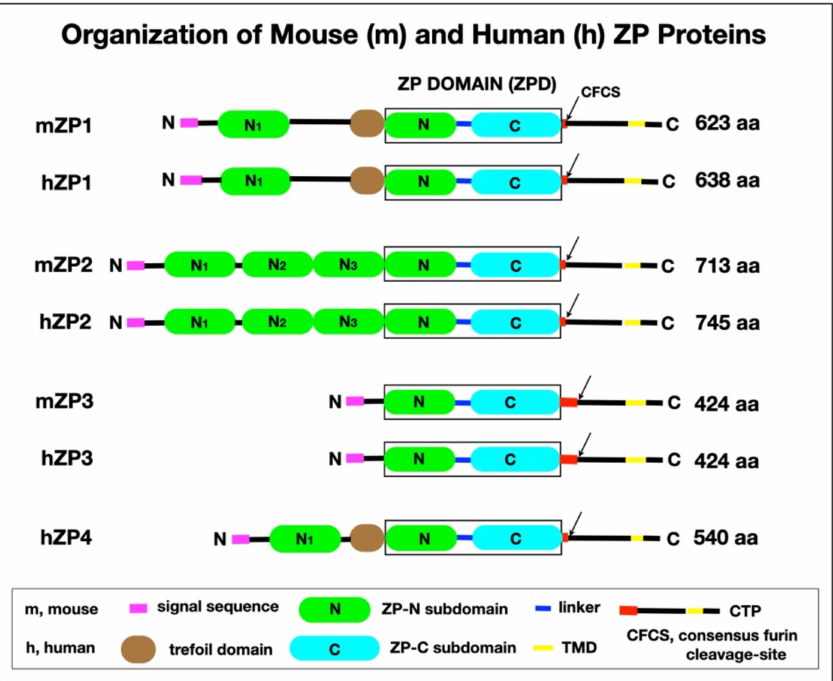
Figure 3. Organization of mZP and hZP proteins. The polypeptide has a signal sequence (magenta), a ZPD that consists of ZP-N (green) and ZP-C (cyan) subdomains, and a linker region (blue); a CFCS (arrow); a TMD) (yellow); and a short CT (black) in the CTP. mZP1, hZP1, and hZP4 also have a TD (brown). mZP2 (713 aa) has 3 additional ZP-N subdomains, N1–N3 (green), between the N-terminus of the polypeptide and the ZPD. mZP1 (623 aa), hZP1 (638), and hZP4 (540 aa) have one additional ZP-N subdomain, N1 (green), between the N-terminus of the polypeptide and the TD. mZP3, the smallest of the 3 mouse ZP proteins (424 aa), consists primarily of a ZPD. mZP1 and mZP2 have only 3 or 4 aa between the ZPD and the CFCS (red), whereas mZP3 has 47 aa, which is a region of positive Darwinian selection during evolution (red) [63] and is the binding site for acrosome-intact, free-swimming sperm during fertilization